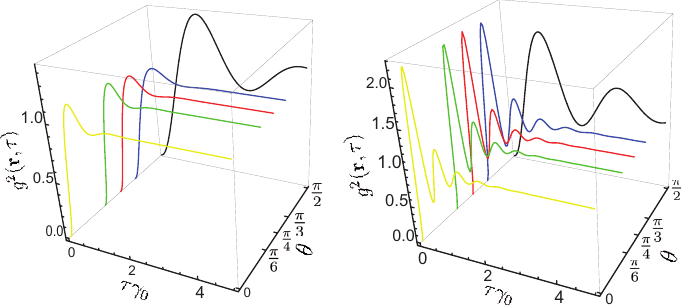
Figure 12. Second-order correlation functions g 2 ( r , τ ) for different values of angle θ for the distance from the surface of 10 nm in the case of a zero detuning from resonance. The laser radiation (Lorentzian profile) linewidth is ∆ ω L = 0 MHz ( left ), ∆ ω L = 1 MHz ( right ).